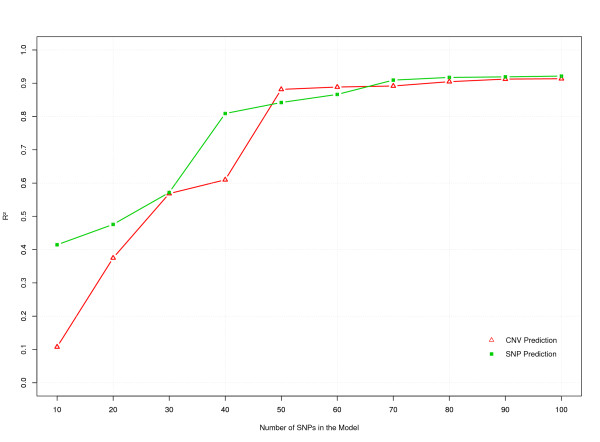
R2 of CNV (red triangles) and dSNP (green boxes) prediction models with different numbers of SNP.